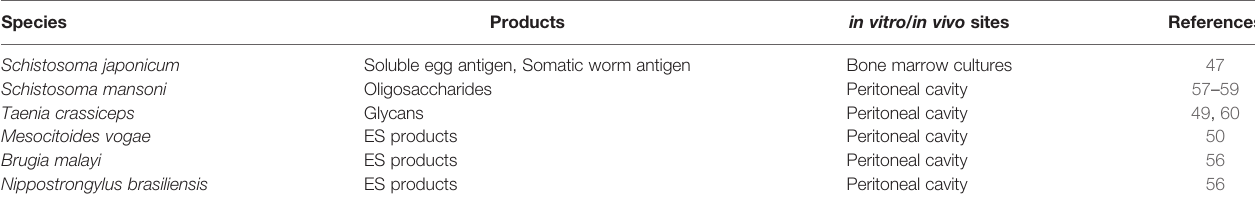
TABLE 2 | Helminth products that induce MDSC differentiation and expansion in vivo and in vitro . Species Products